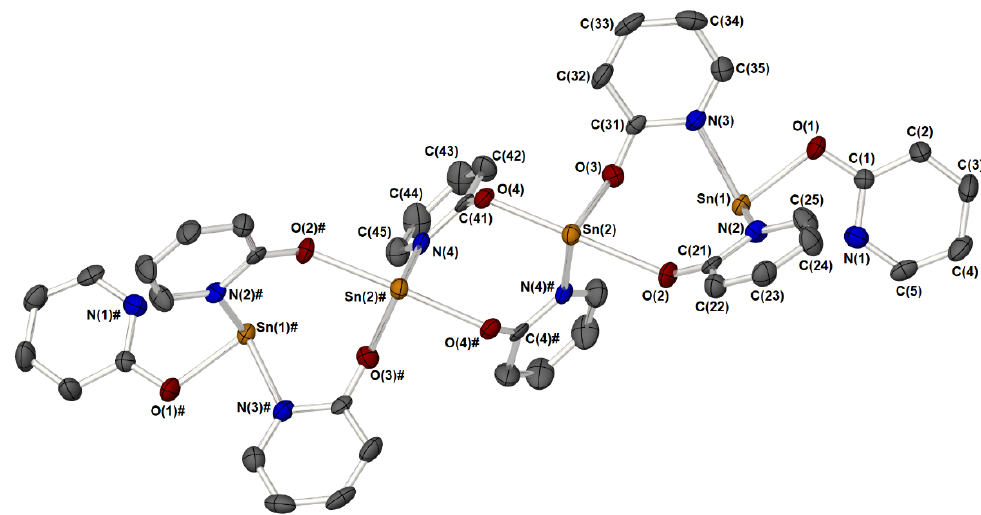
Figure 6. The solid-state molecular structure of complex 2 . Symmetry transformations (#) used to generate equivalent atoms; #: 3/2 − X, Y, 1 − Z. Thermal ellipsoids are shown at 50% probability. Hydrogen atoms have been omitted for clarity.